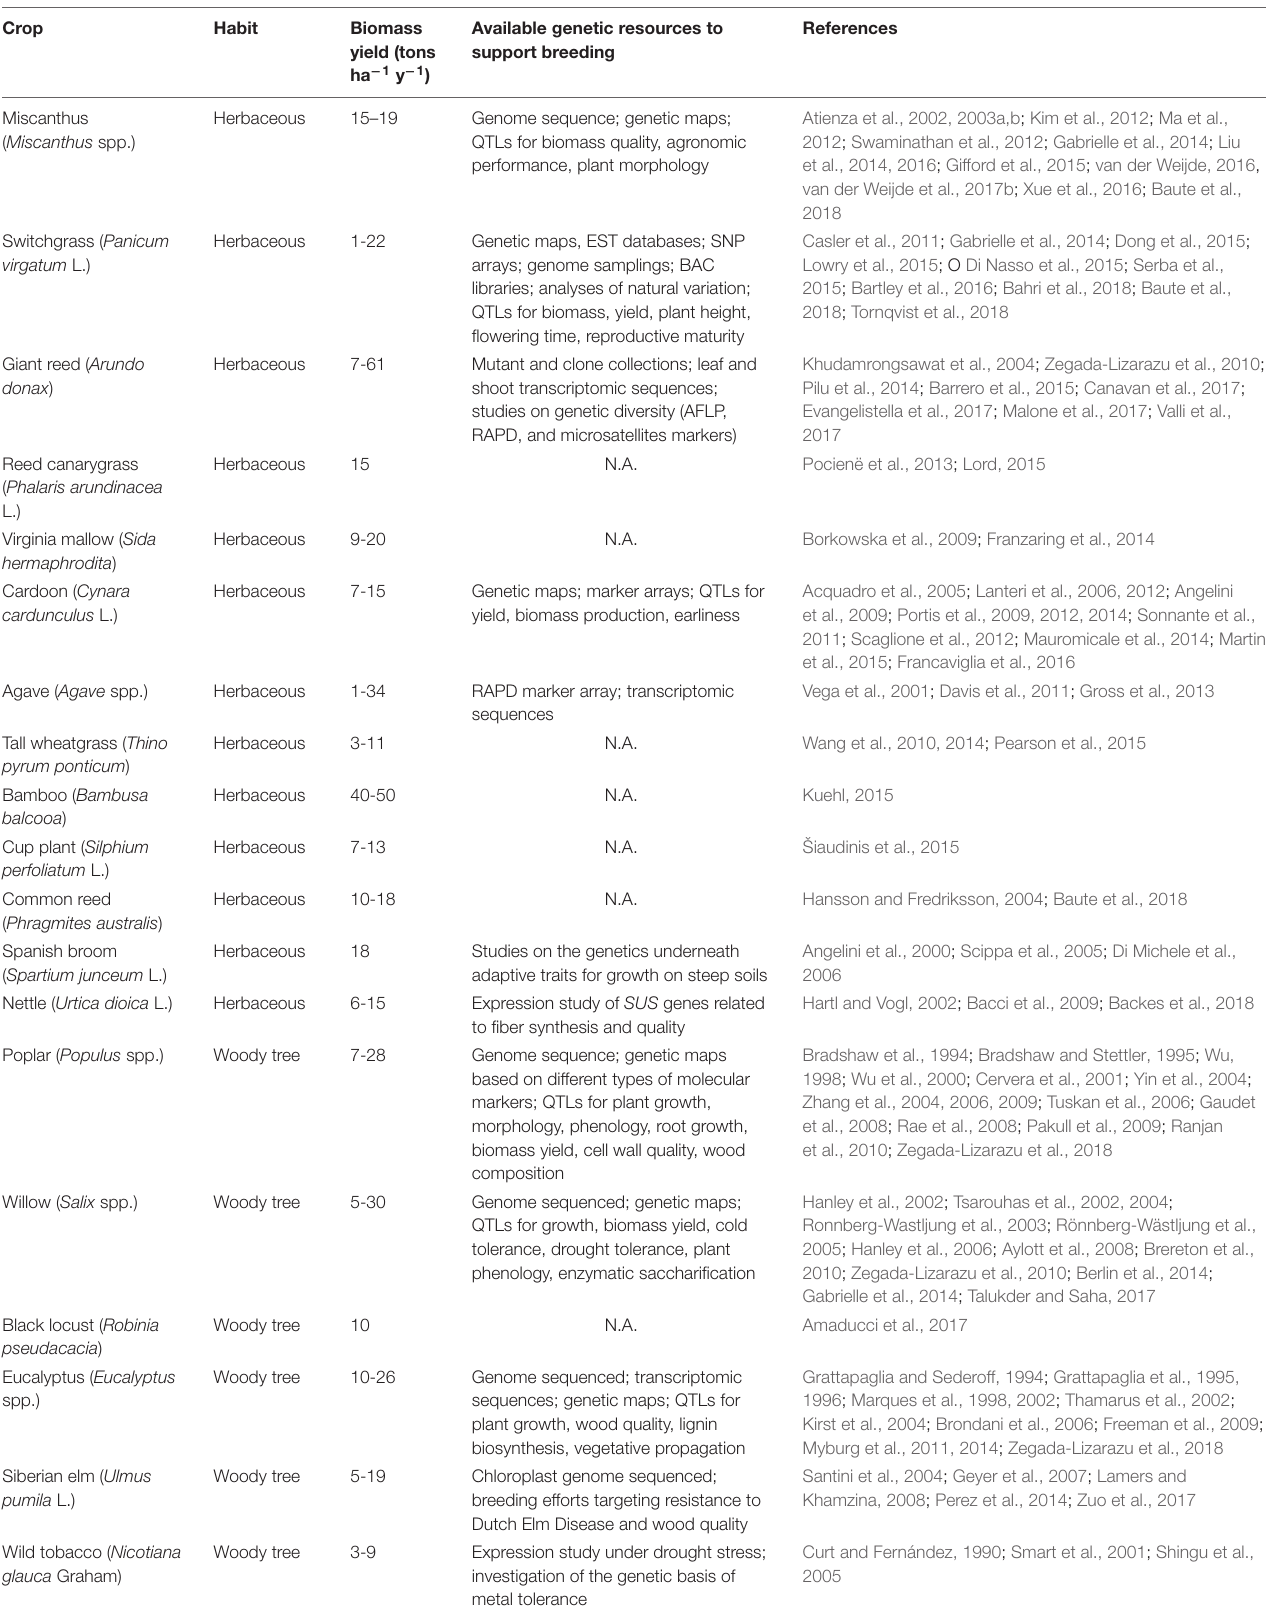
TABLE 1 | Promising perennial lignocellulosic crops for cultivation on MALs.